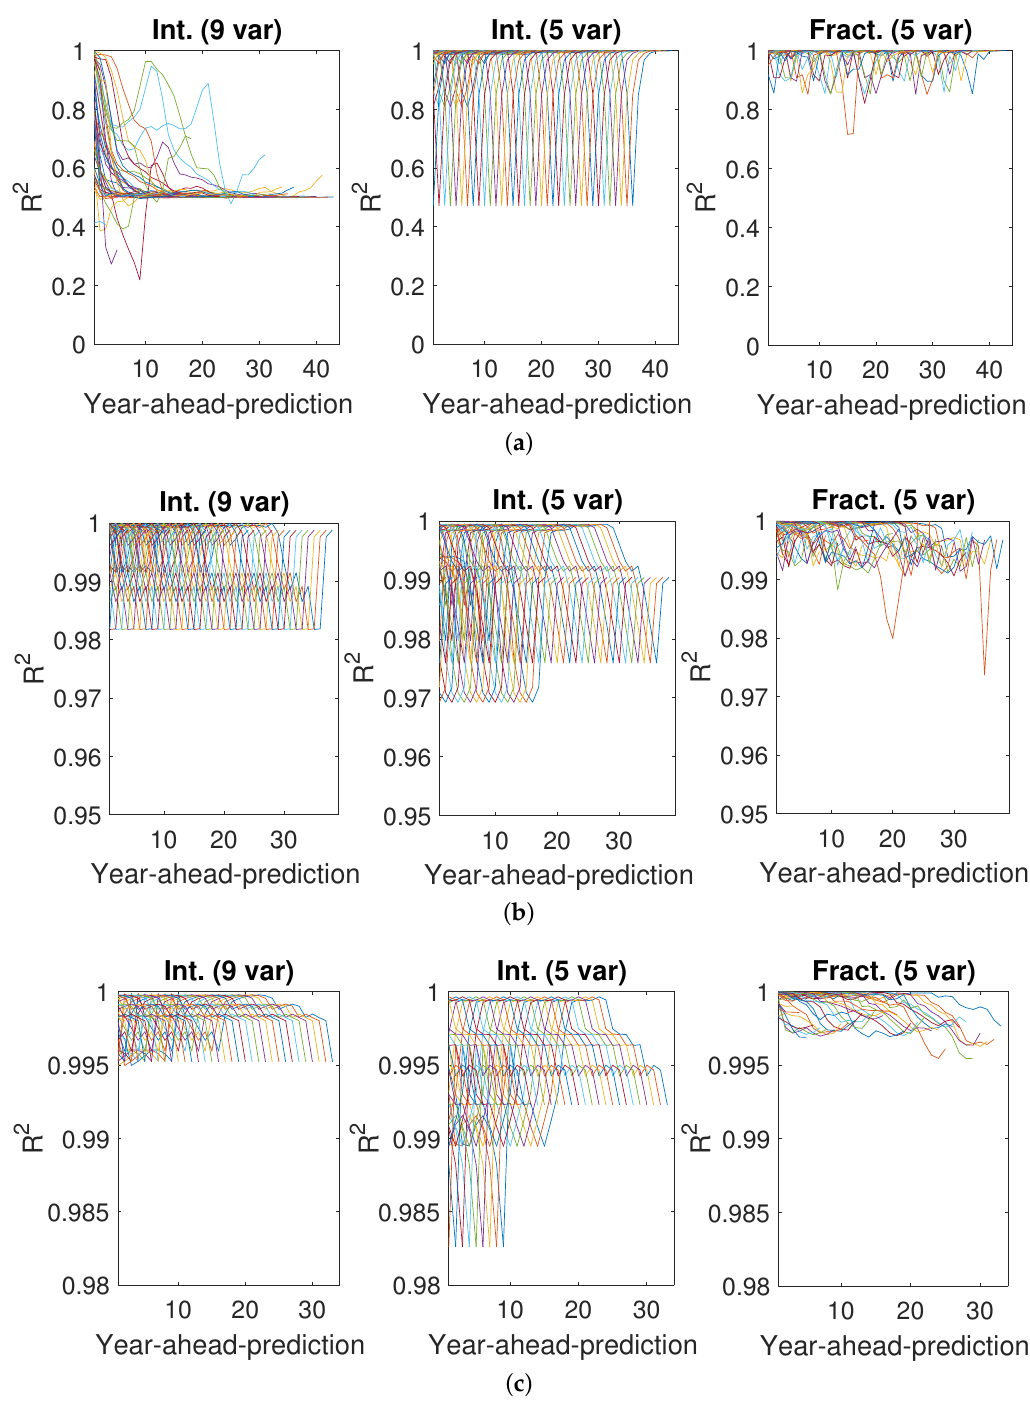
Figure 6. R 2 values of GDP estimates for the European Union. Estimates were obtained with models (1) (left), (2) (middle), and (3) (right). The models were obtained with data for different numbers of years: ( a ) N = 5 (top) ( b ) N = 10 (center) ( c ) N = 15 (bottom). The models were used to estimate the GDP for as many years as possible after the period for which they were built. The scale of the y -axis is not the same for all models and all values of N